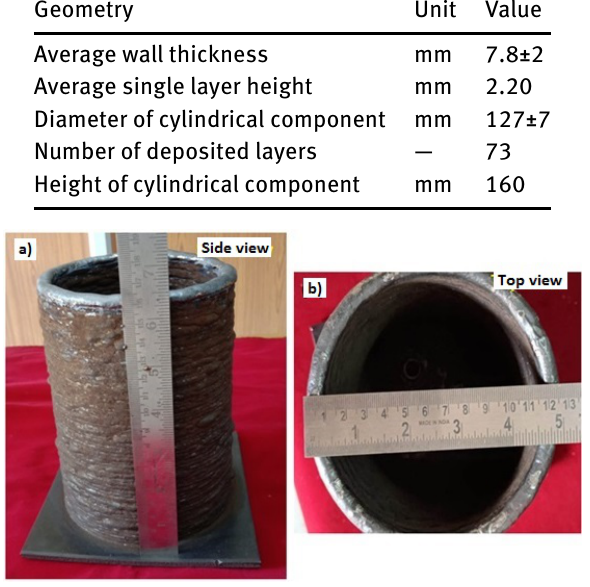
Figure 3: Photograph of the Low carbon steel straight cylindrical component (as fabricated) a) side view and b) top